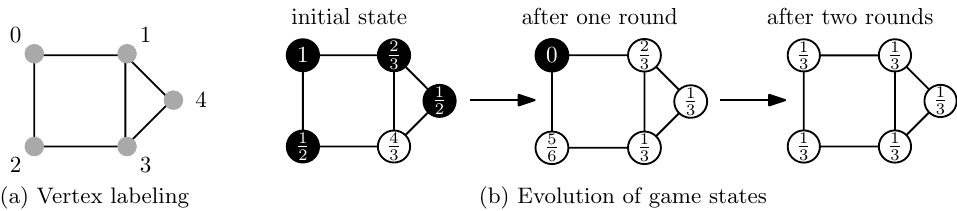
Figure 1: (a) An example of an underlying graph for the ESPD. (b) An evolution of states of the ESPD on the underlying graph in (a) for the parameter values a = 4 a solid vertex represents a cooperator, while an open vertex represents a